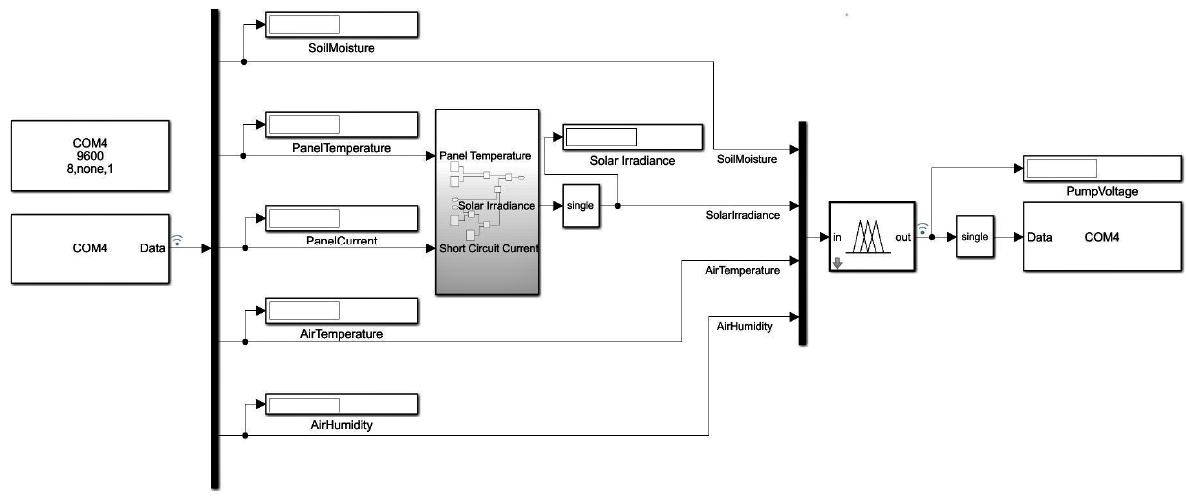
Figure 17. Simulink model.